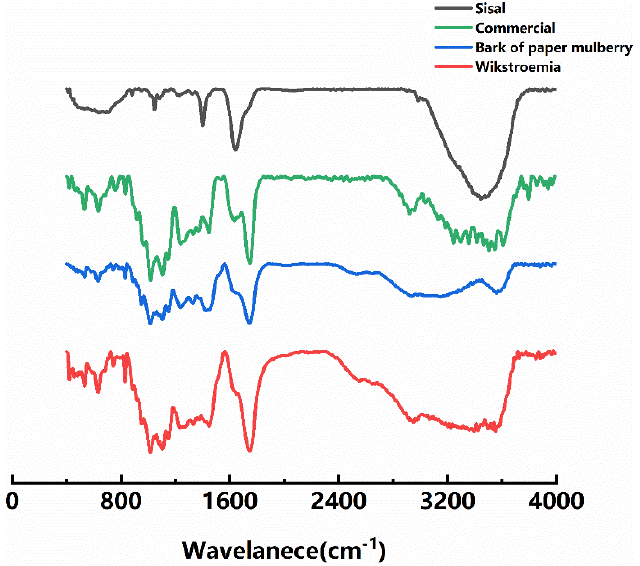
Figure 1. FT-IR spectra of different pectin